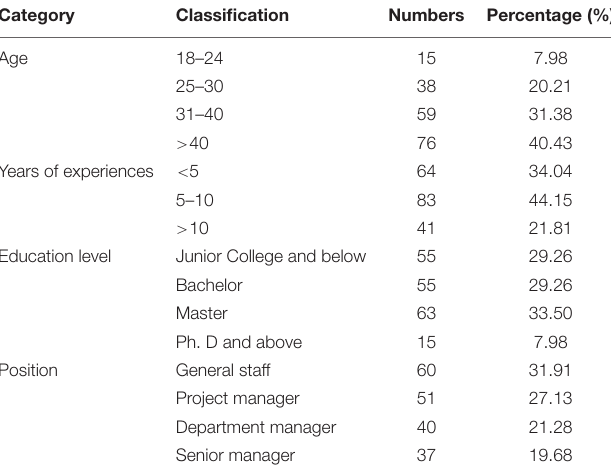
TABLE 2 | Profiles of